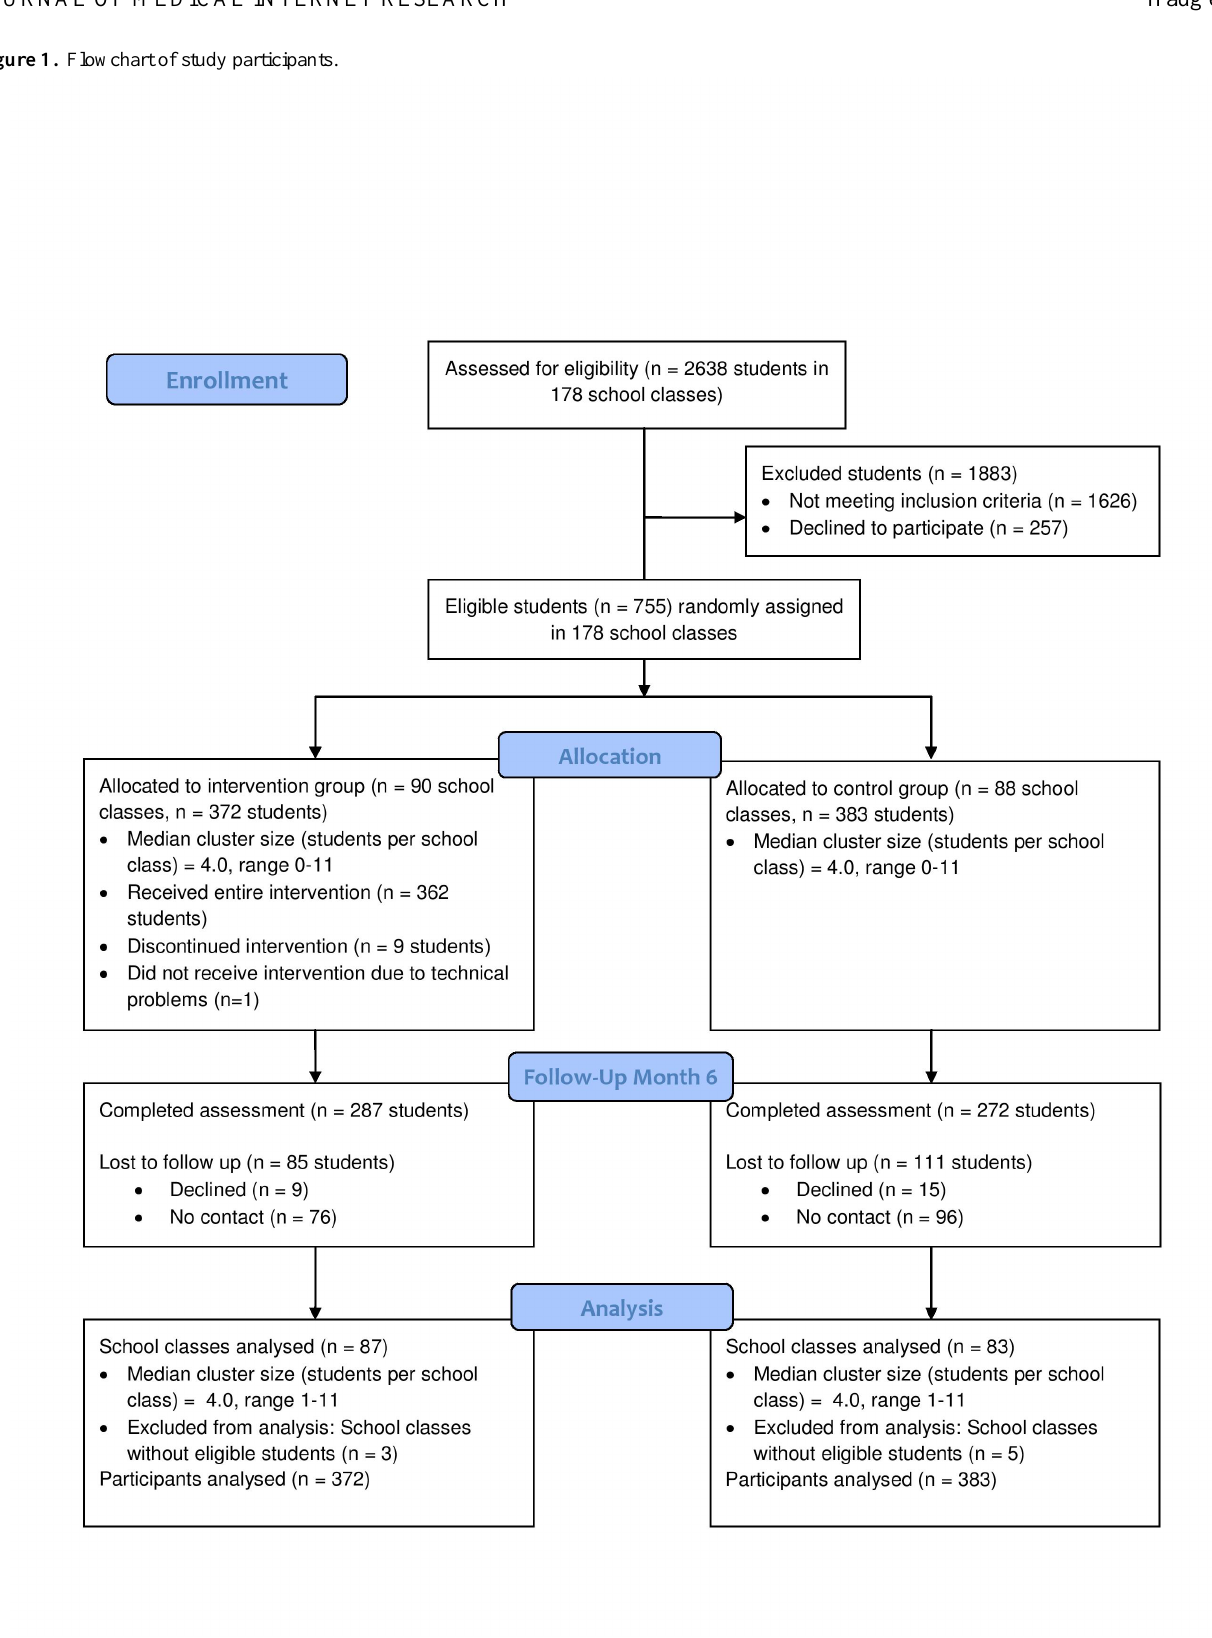
Figure 1. Flowchart of study